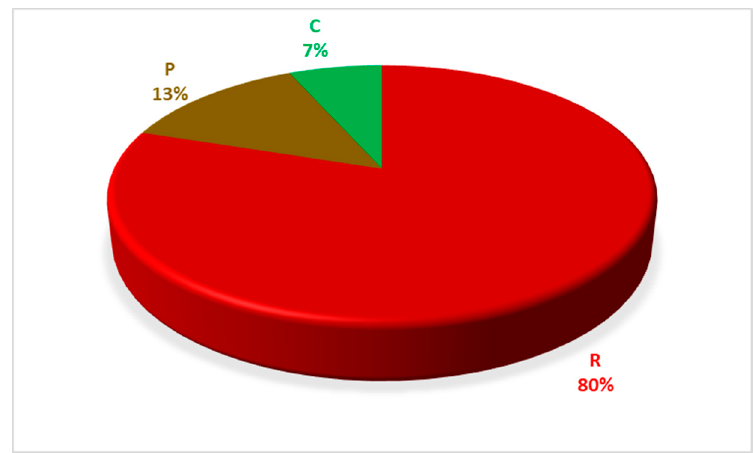
Figure 6. Pie chart showing the percentage of Rhodophyta, Phaeophyta and Clorophyta present on the drift net.